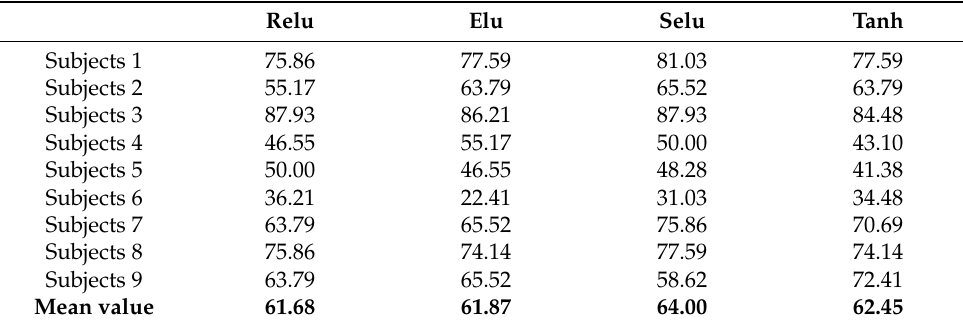
Table 6. Classification accuracy of the proposed modified merged CNNs methods